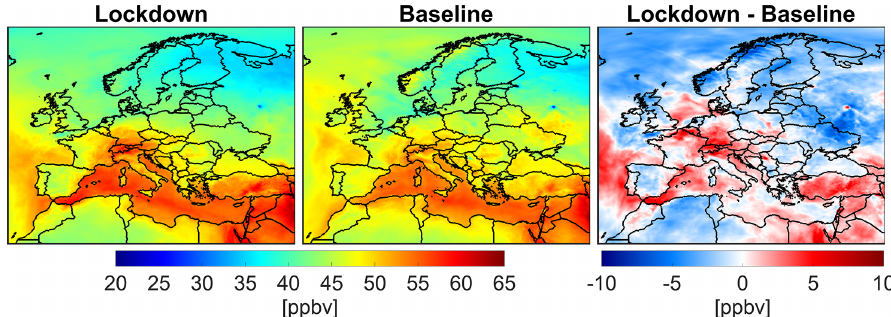
Figure 7. Simulated surface MDA8 ozone concentration using the constrained model in the month of April 2020 (lockdown), April 2019 (baseline), and their difference.